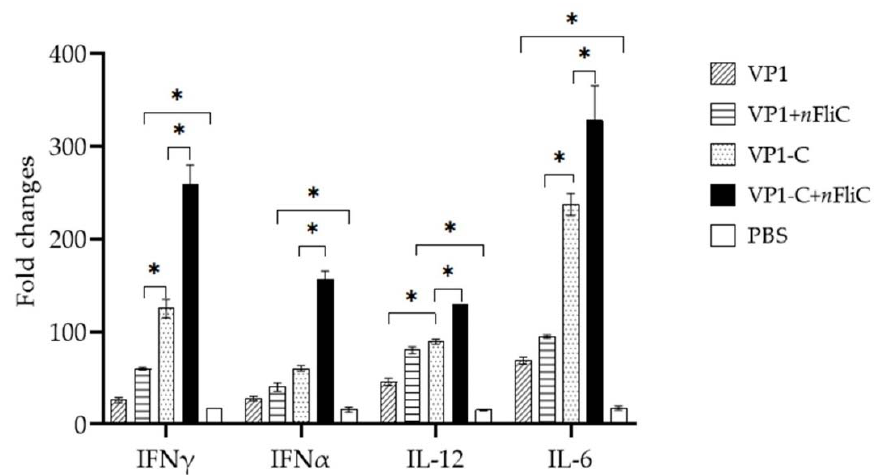
Figure 4. Cytokine expression profile of PBMCs from vaccinated ducklings. Ducklings ( n = 3 per group) were vaccinated once with five different vaccine formulations: (1) VP1, (2) VP1 + n FliC, (3) VP1-C, (4) VP1-C + n FliC, and (5) PBS. Isolated PBMCs (Day 14) were stimulated with VP1, and RT-